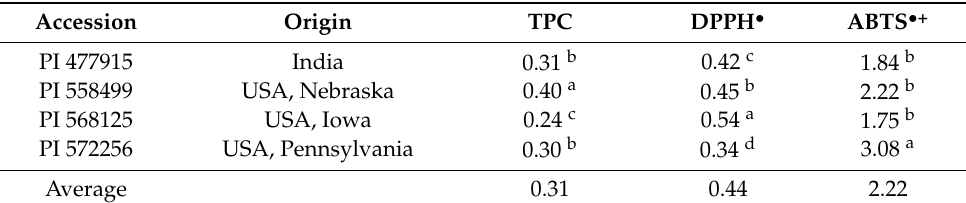
Table 5. Mean values of three replications of antioxidant properties in the four accessions of A. hypochondriacus